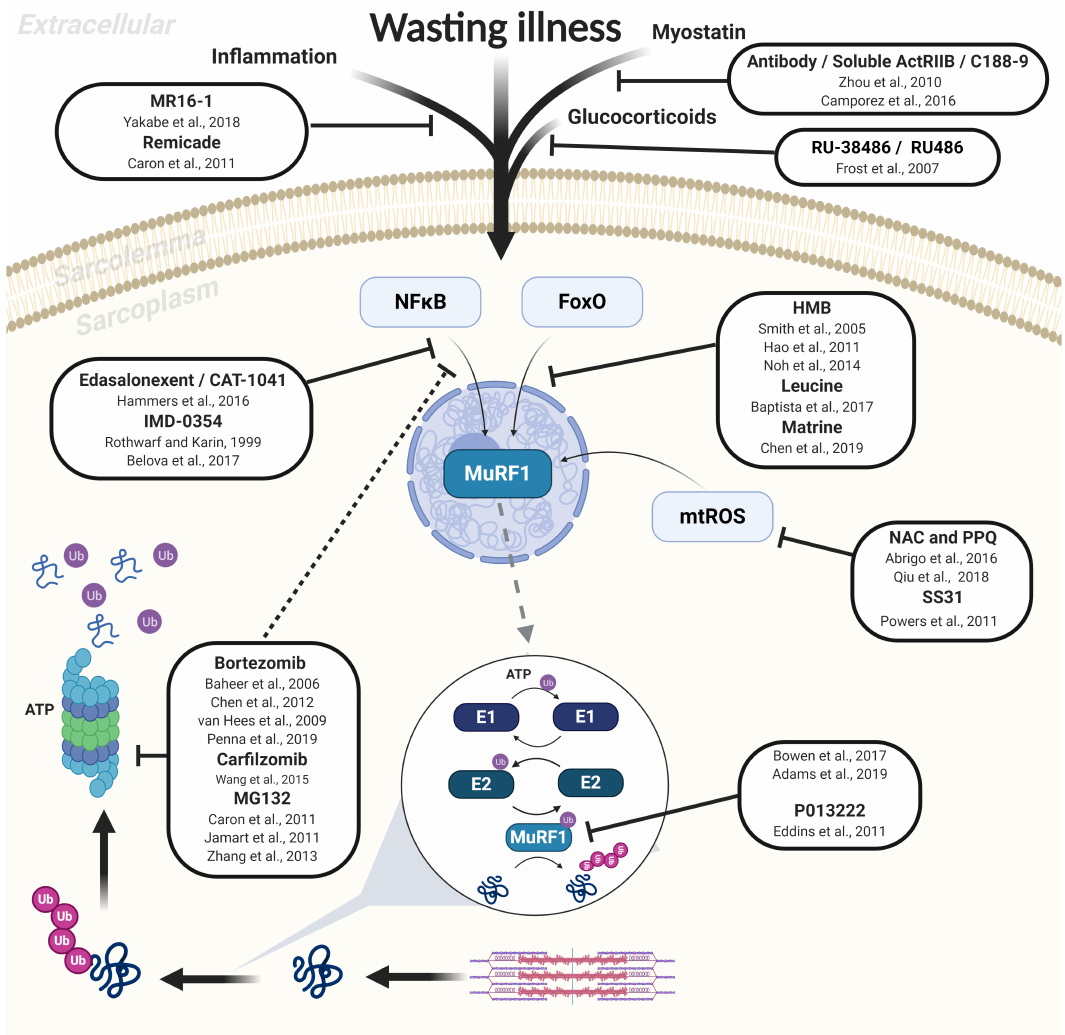
Figure 1. Overview of proteasome-dependent protein degradation via the muscle-specific E3 ligase MuRF1 as induced in various wasting illness, with recognized pharmacological inhibitors also presented. The most important proteolytic pathway to mediate muscle atrophy is the ATP-dependent ubiquitin-proteasome system, whereby structural and regulatory proteins are degraded by the 26S proteasome following polyubiquitination that involves activation of E1, E2, and E3 enzymes. MuRF1 (an E3 ligase) plays a fundamental role in tagging proteins with ubiquitin during catabolic conditions, which is activated by various stimuli and signaling pathways that include NF κ B and FoxO. A selection of reported pharmacological inhibitors of MuRF1-dependent muscle atrophy are presented along with the study reference. Solid lines indicate a direct e ff ect on the target, while dotted lines indicate a secondary indirect e ff ect. See the main text for full